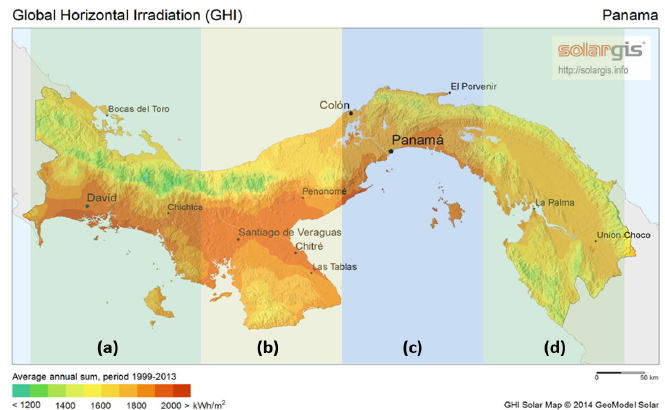
Figure 6. Areas with different climate-types within the humid tropical climate in Panama: ( a ) area with tropical forest and template-like zone, ( b ) arid area, ( c ) highly urban regions rounded by tropical forest, ( d ) area with heavy tropical forest. All areas possess coastal zones. SolarGIS c (cid:13) 2014 GeoModel